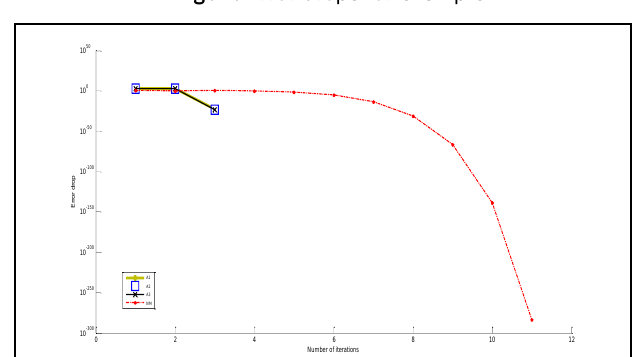
Fig. 7. Error drops for example 4